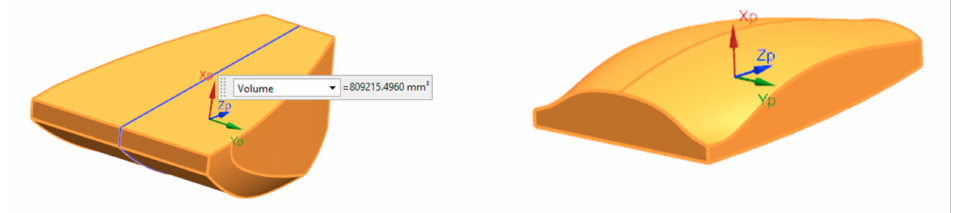
Figure 19. Volume quantification